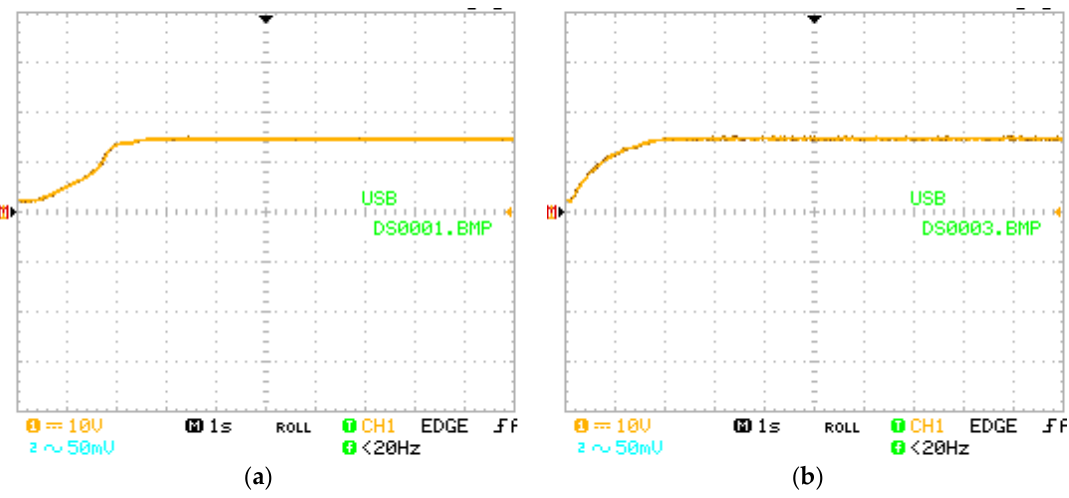
Figure 19. ( a ) PV Voltage and ( b ) PV Power of modified P&O algorithm.